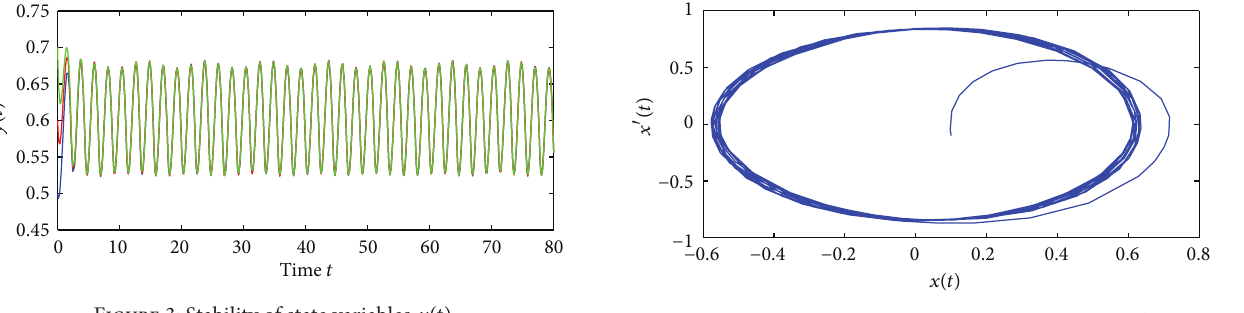
Figure 5: Phase response of state variables 𝑥(𝑡) and 𝑥 󸀠 (𝑡) .